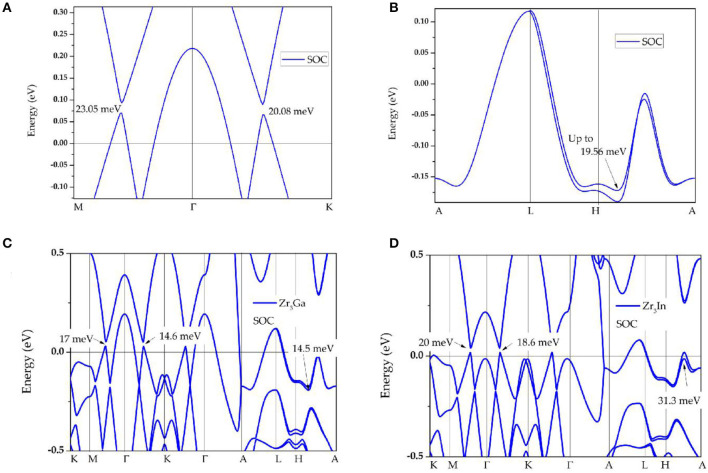
(A,B) Band structures of Zr3Al in the presence of spin–orbit coupling in region A and B, respectively; (C,D) band structures of Zr3Ga and Zr3In in the presence of spin–orbit coupling effect.